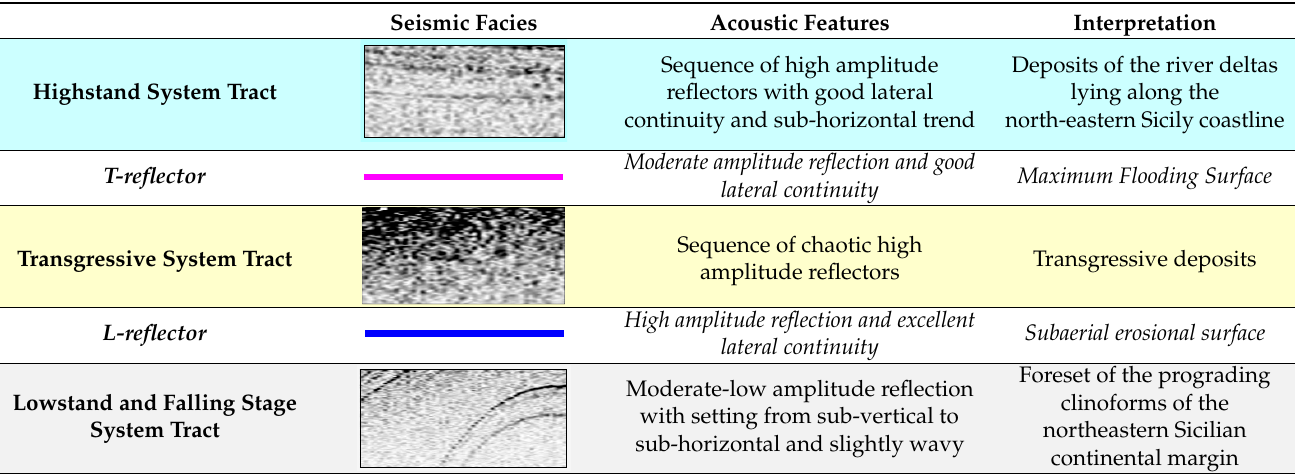
Table 1. Facies analysis and stratigraphic position of the depositional units interpreted in this study.